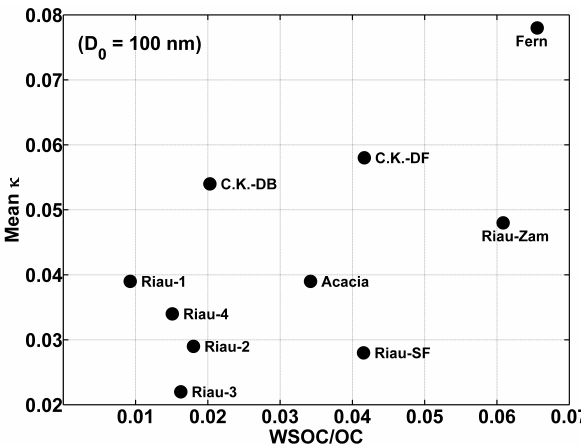
Figure 5. Correlation of κ and WSOC / OC ratios for different types of Indonesian peat and